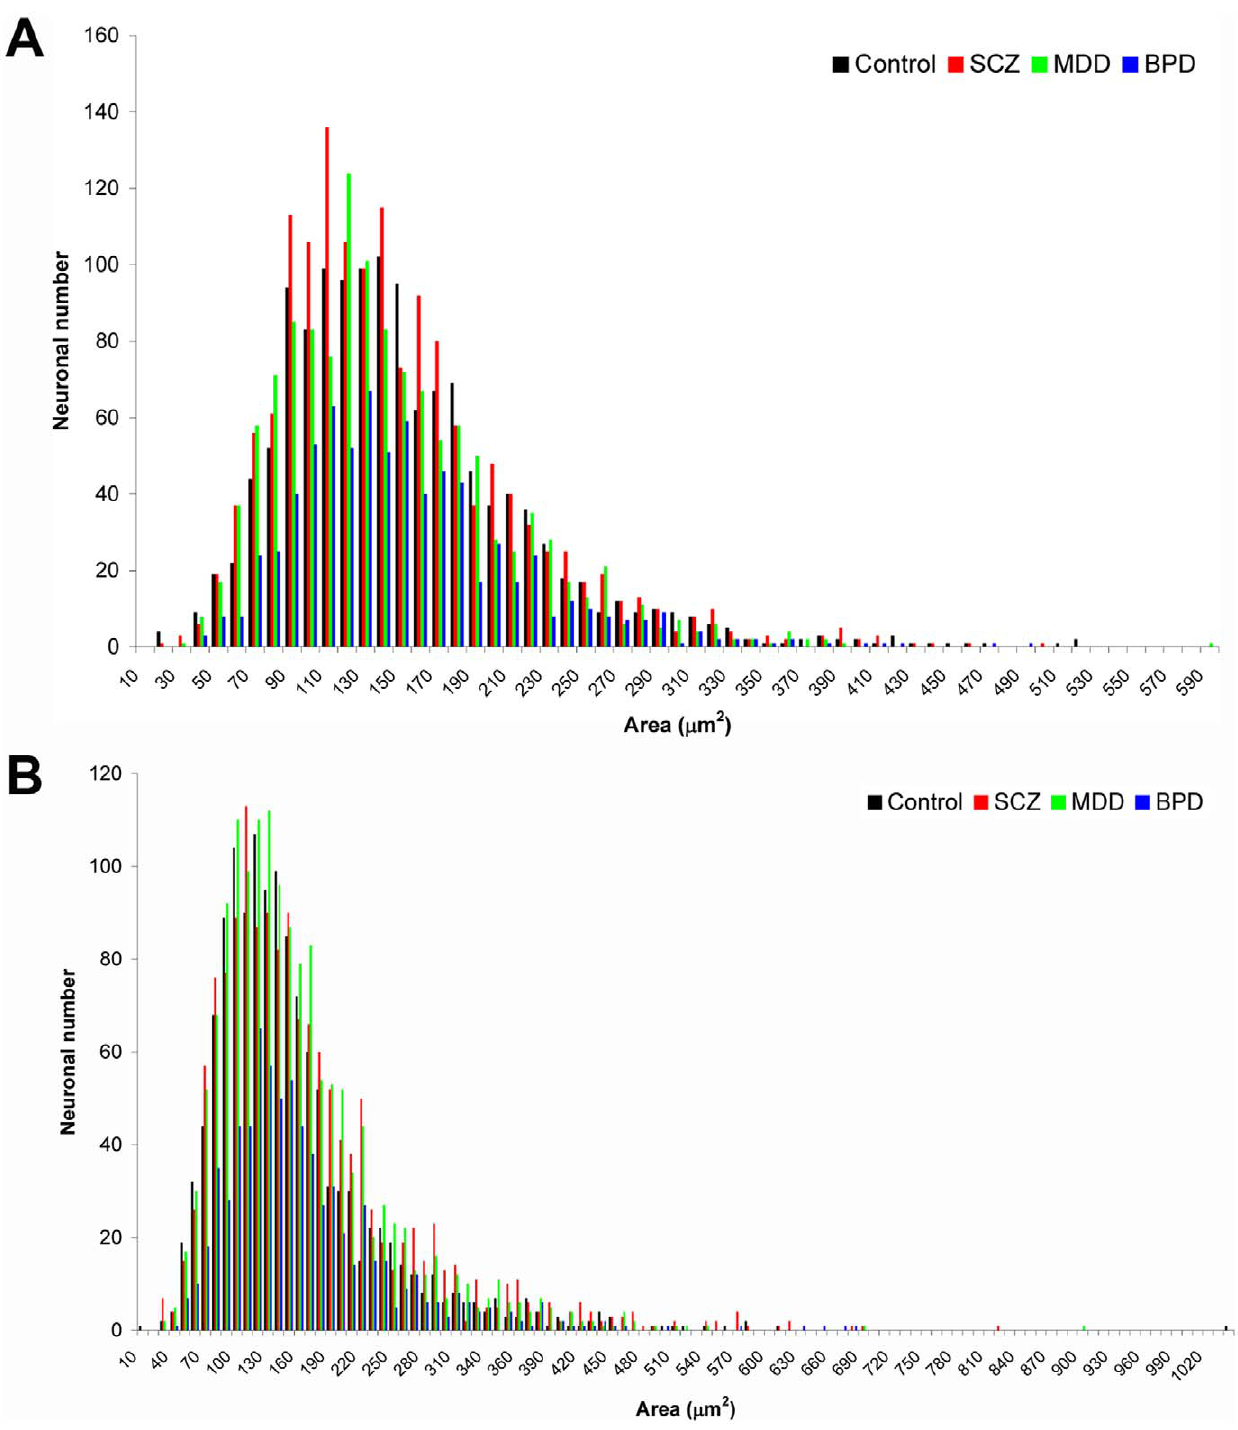
Figure 3. Distribution of MR-GEF-expressing neuronal sizes by group for cortical layers II and IV. Comparison of the range of somal sizes of MR-GEF expressing neurons in layer II (A) and layer IV (B) of the DLPFC. Abbreviations: BPD, bipolar disorder; MDD, major depressive disorder; SCZ, schizophrenia.